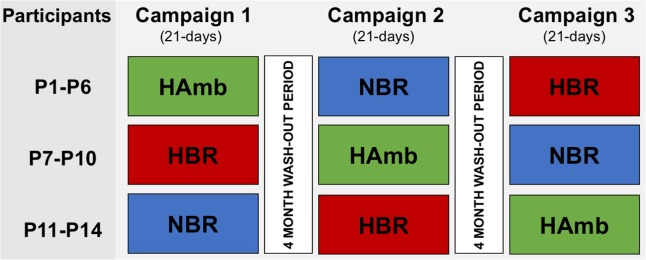
Cross-over designed allocation of the 14 participants (P1–P14) to the respective interventions (NBR, normoxic bed rest; HBR, hypoxic bed rest; HAmb, hypoxic ambulation) during the course of the project.